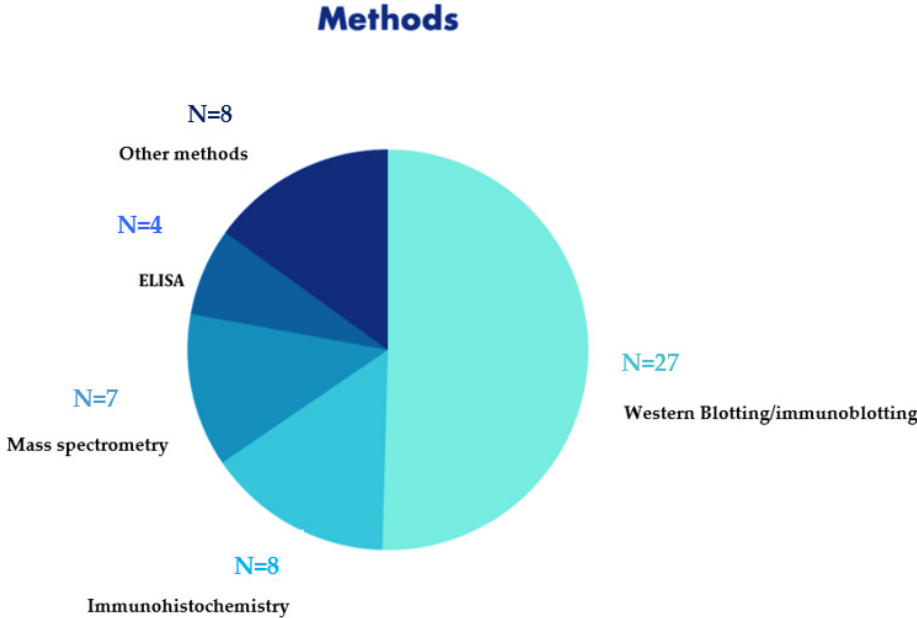
Figure 4. Overall frequency of analysis of the methodologies examined in the studies selected for the review (N=number of studies).